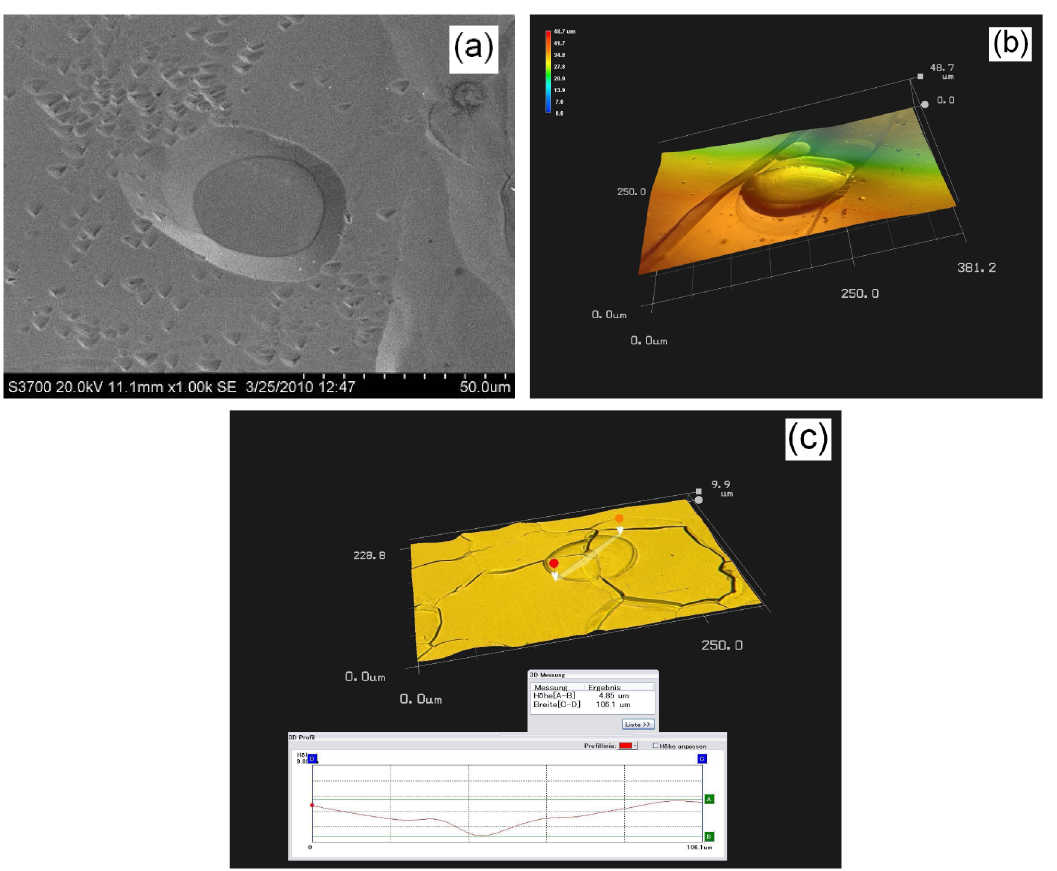
FIG. 14. Examples of images and depth profiles of pits. Pits are shallow and